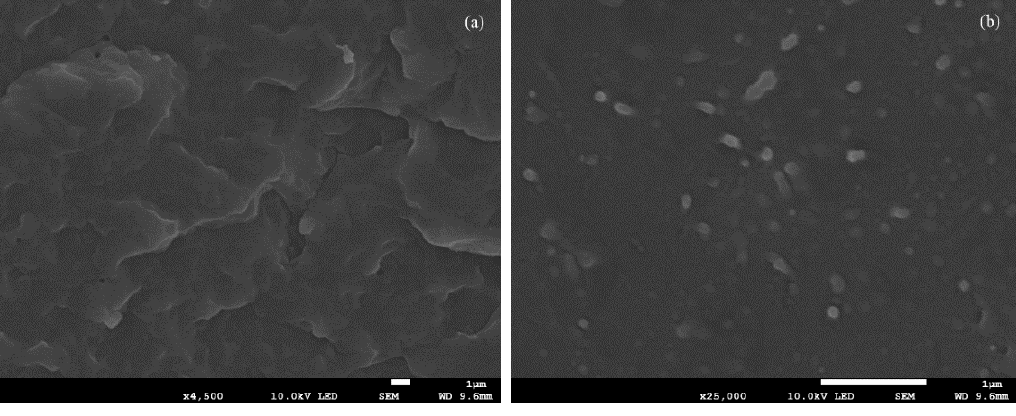
Figure 1. SEM images of ( a ) PHS and ( b ) PHS/CNC1.